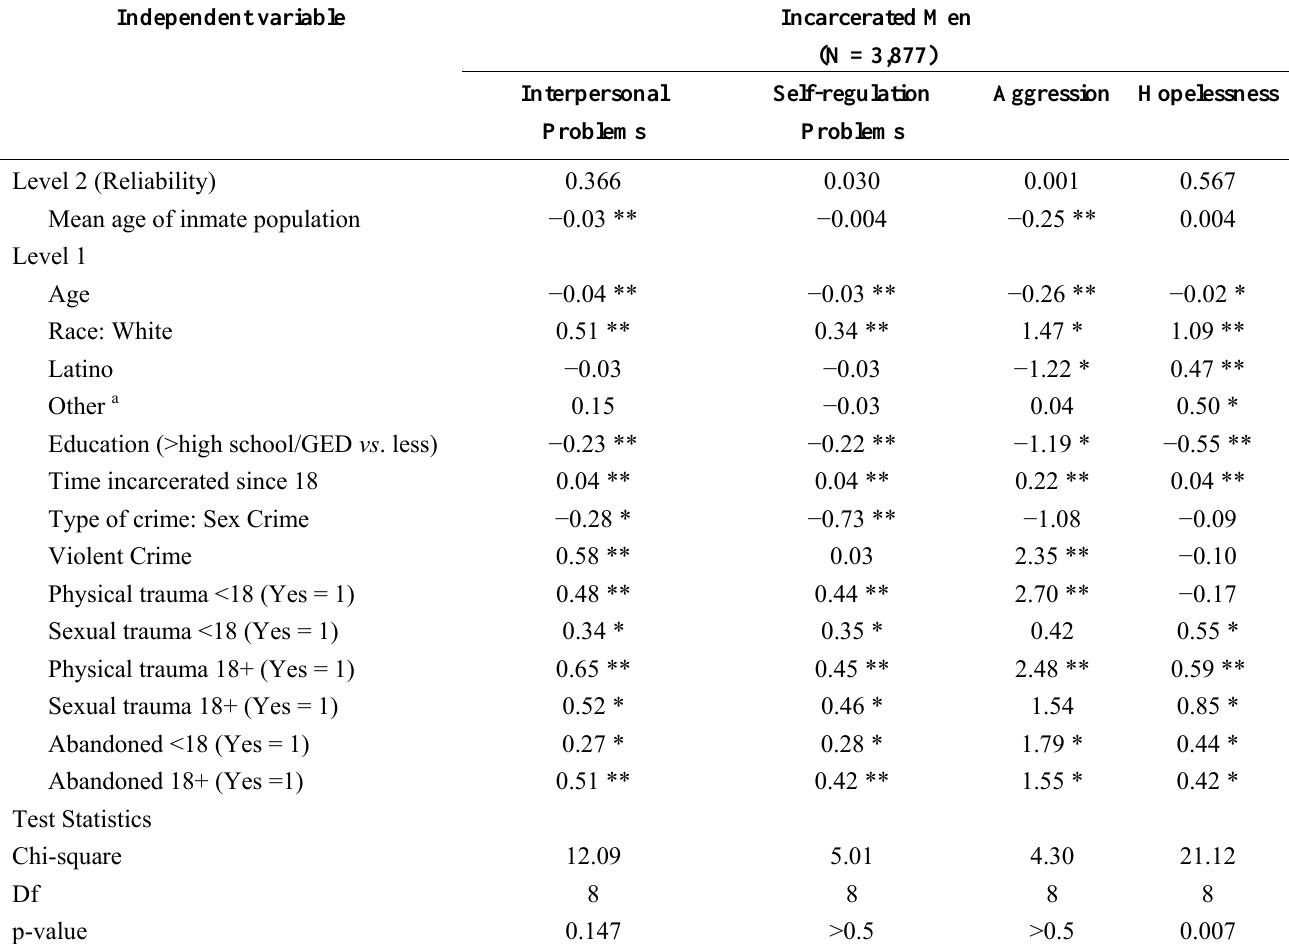
Table 4. Coefficients for behavior problems of individual characteristics of incarcerated